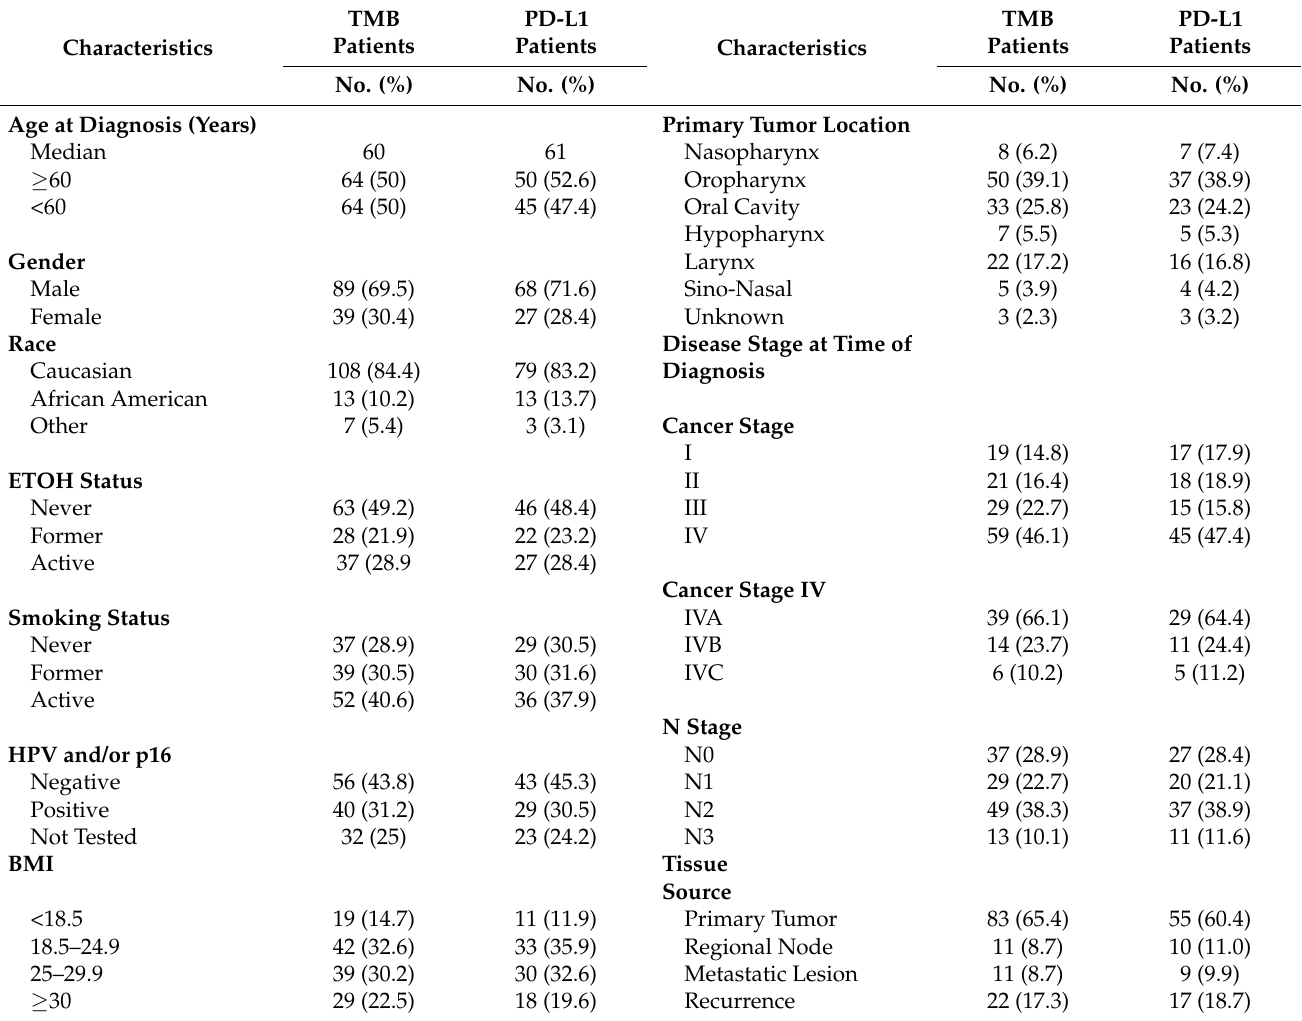
Table 1. Characteristics of all patients included in the